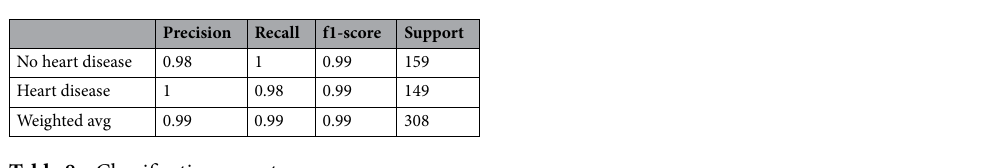
Table 8. Classification report.